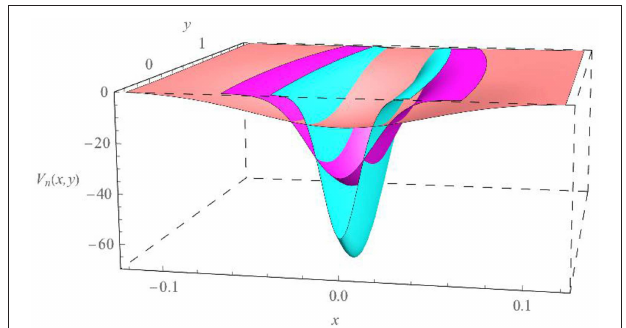
ne − ( n 2 x 2 + y 2 ) for n =